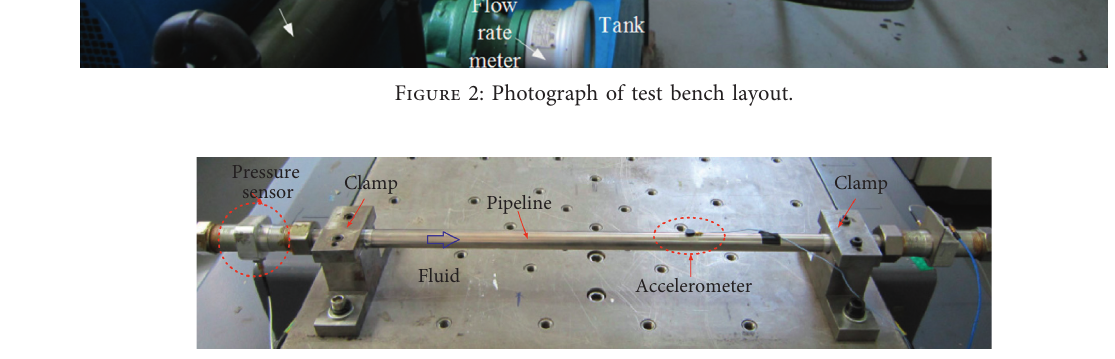
Figure 3: Placement of the pressure sensor in the pipeline system. Table 1: The specification of testing instruments and experimental